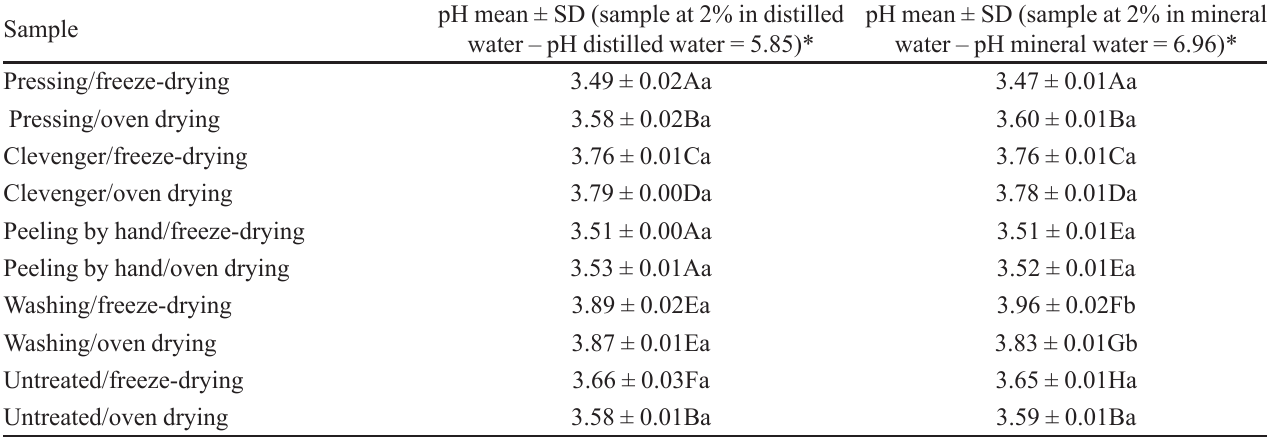
*Different lower case letters indicate statistically significant variation between values of the same row (p < 0.05); different uppercase letters indicate statistically significant differences between means of the same column (p <